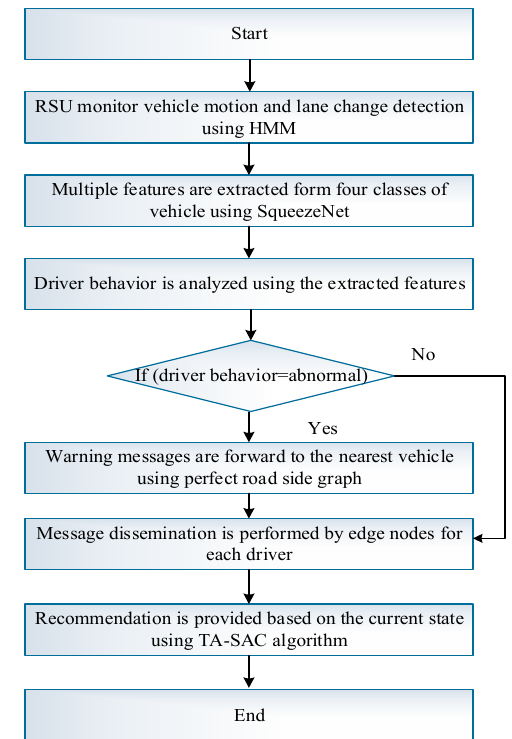
RSU monitor vehicle motion and lane change detection using HMM